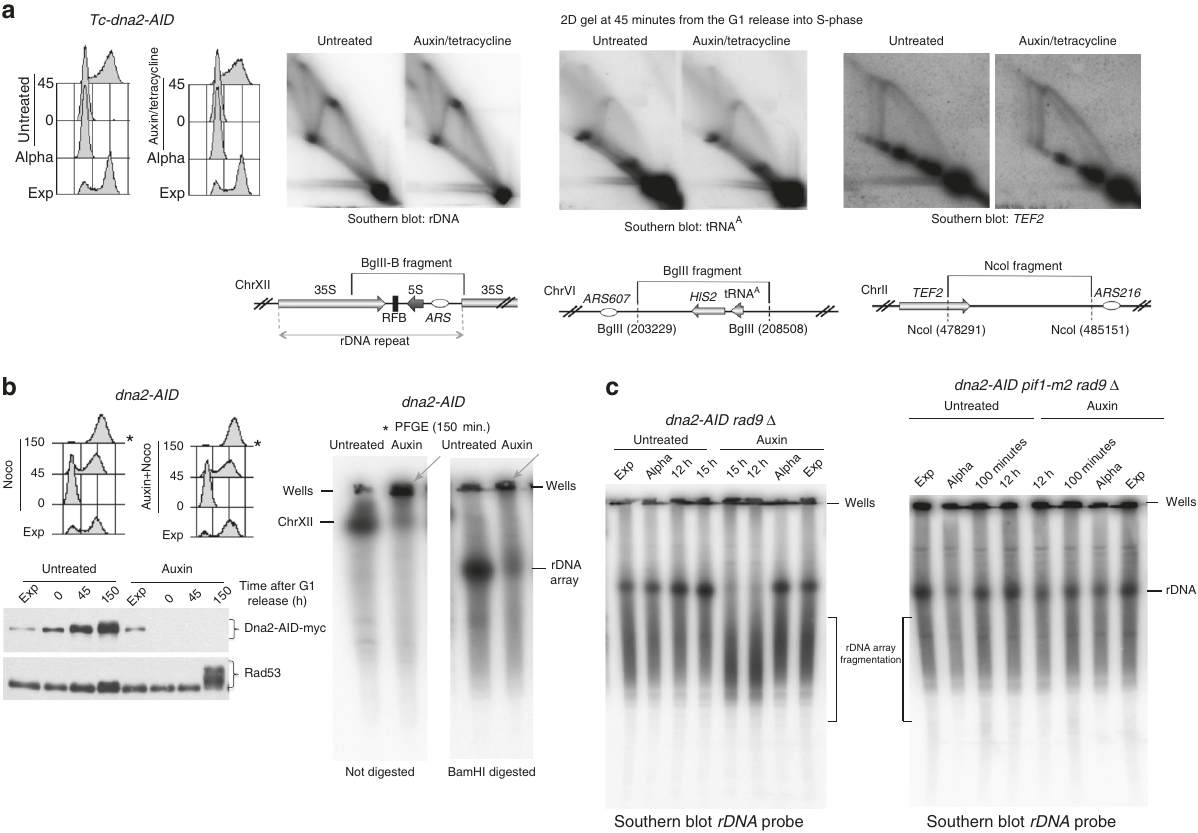
Fig. 4 Dna2 depletion does not cause fork pausing in the fi rst cell cycle but it induces Pif1-dependent rDNA fragmentation in dna2-AID rad9 cells grown for 4-5 cell divisions in the absence of Dna2. a Neutral – neutral 2D gel electrophoresis of RIs at the three indicated natural pausing sites after a single unperturbed S phase in Tc-dna2-AID cells depleted (Auxin) or non-depleted (Untreated) for Dna2. b Chromosome XII and isolated rDNA array ( Bam HI in plugs digestion 74 ) migration patterns were analysed by pulsed fi eld gel electrophoresis (PFGE) and Southern blotting in dna2-AID cells depleted (Auxin) or non-depleted (untreated) for Dna2 at 150 min from the G1 release into S phase. Cellular DNA content, dna2-AID-myc protein level, and Rad53 hyper- phosphorylation were detected, respectively, by FACS and western blotting. Grey arrows indicate retention of RIs into the wells of the PFGE gels. Position of the wells of the PFGE, Chromosome XII, and the rDNA array bands are indicated by black lines. c The length of the rDNA array was determined as in ( b ) at the indicated time points from the G1 release into S phase in dna2-AID rad9 Δ and dna2-AID pif1-m2 rad9 Δ cells depleted (Auxin) or non-depleted, (untreated) for Dna2. Fragmentation of the rDNA array is indicated by black